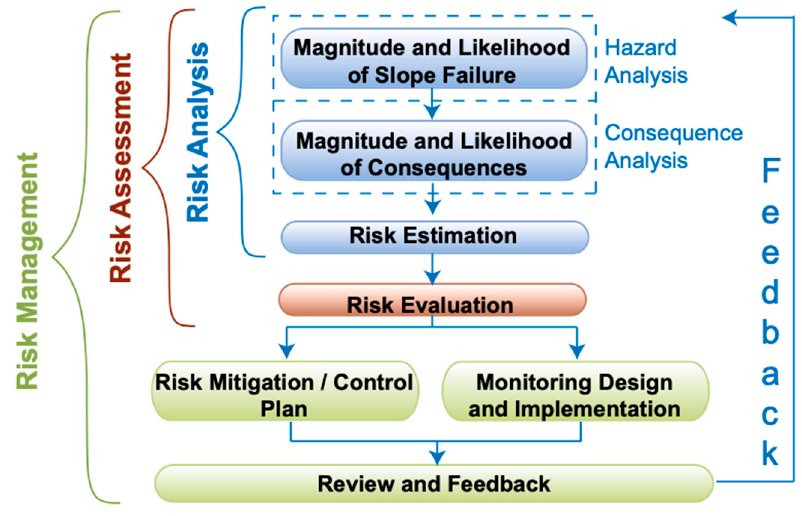
Figure 1. General risk management framework for landslides in natural and cut slopes. After [11].